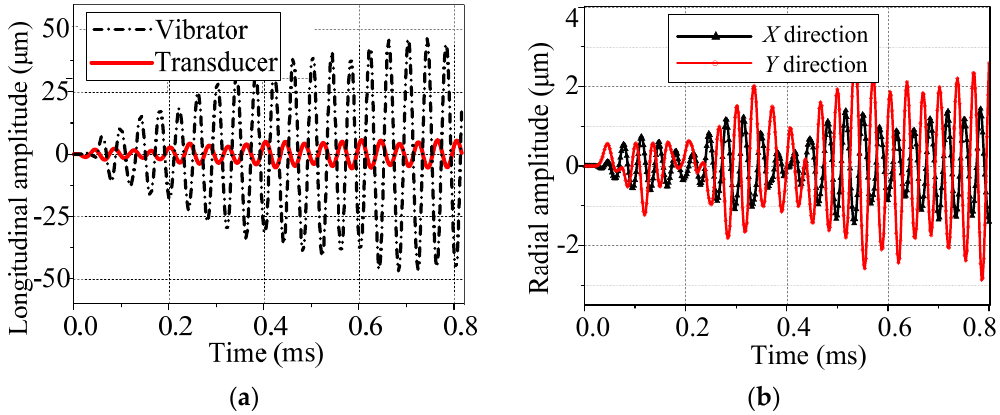
Figure 12. Transient analysis of the power-superimposing vibration system driven by square wave voltages with a phase difference of 120°. ( a ) Longitudinal amplitude of vibrator and transducers. ( b ) Radial amplitude in X and Y directions.